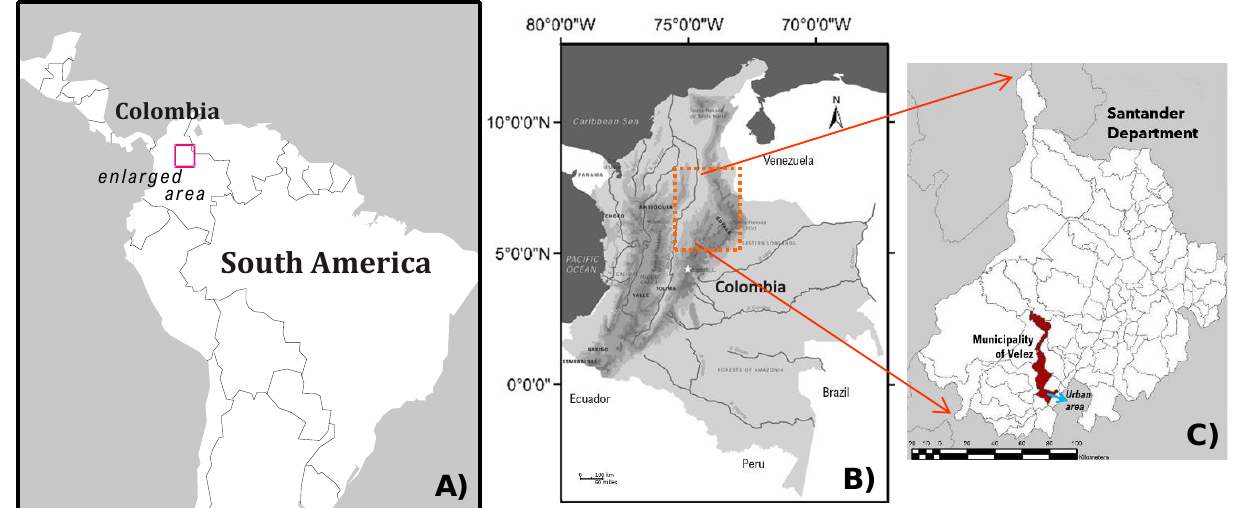
Figure 3. Continental ( A ) and national location of Santander in Colombia ( B ), and the municipality of Vélez ( C ), the urban area at the bottom.